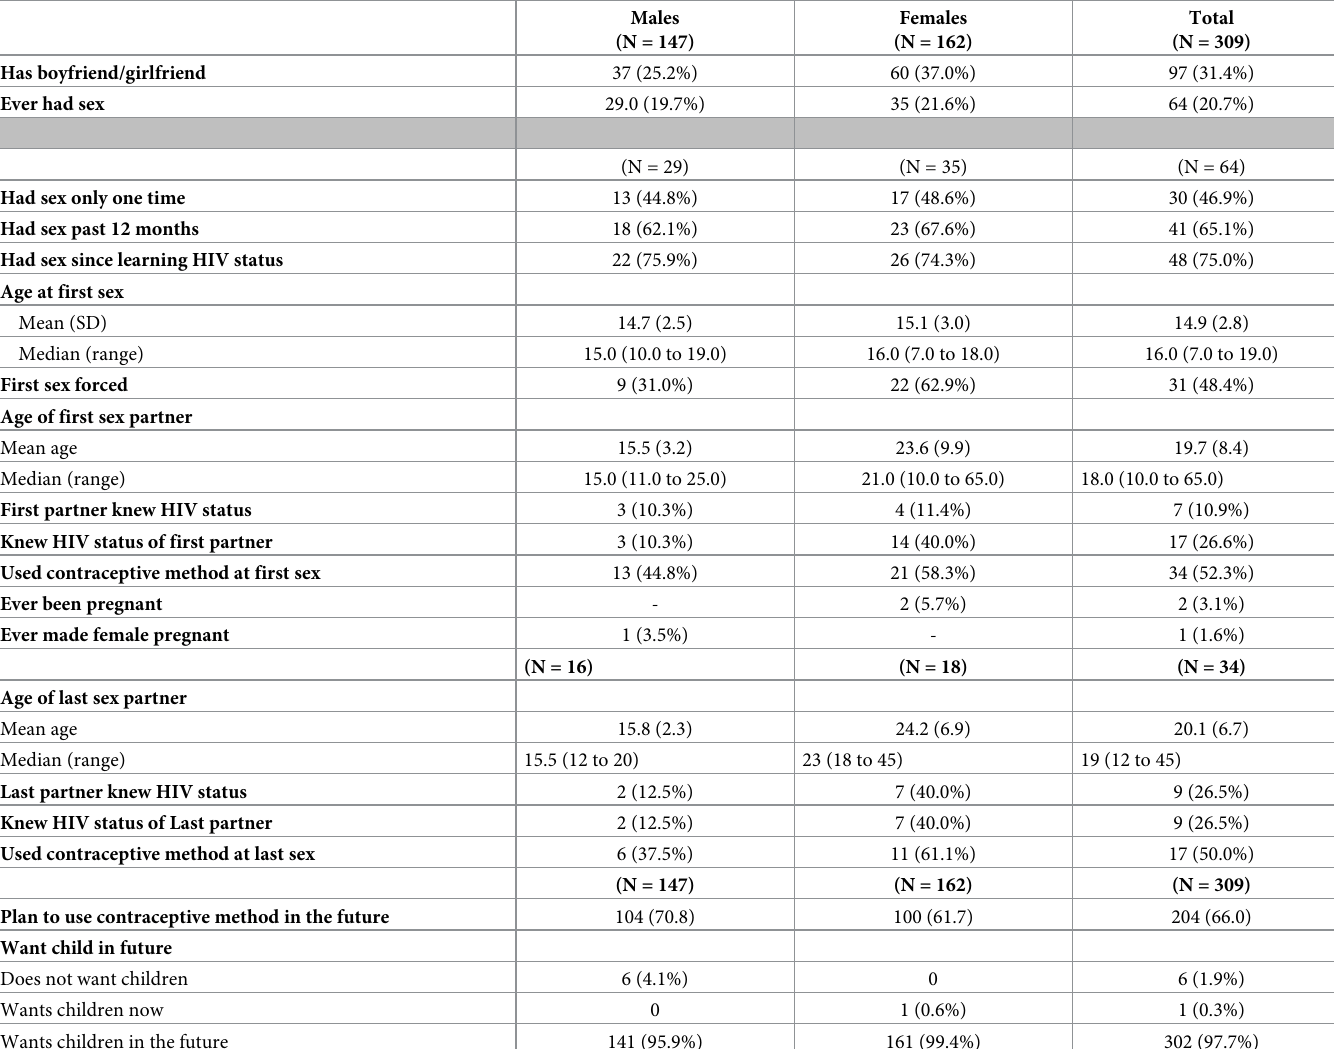
Table 3. Sexual and reproductive health characteristics of study participants stratified by